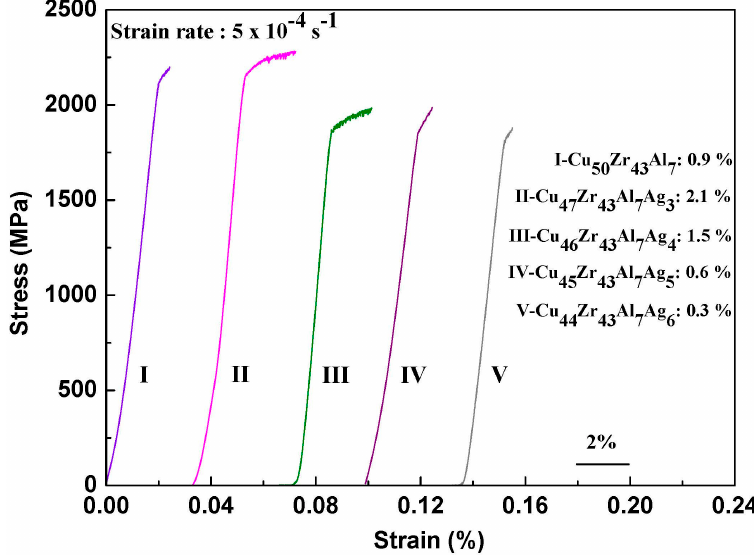
Figure 3. Compressive stress ‐ strain curves of the Cu 50 − x Zr 43 Al 7 Ag x ( x = 0, 3, 4, 5, 6) rods at room temperature.